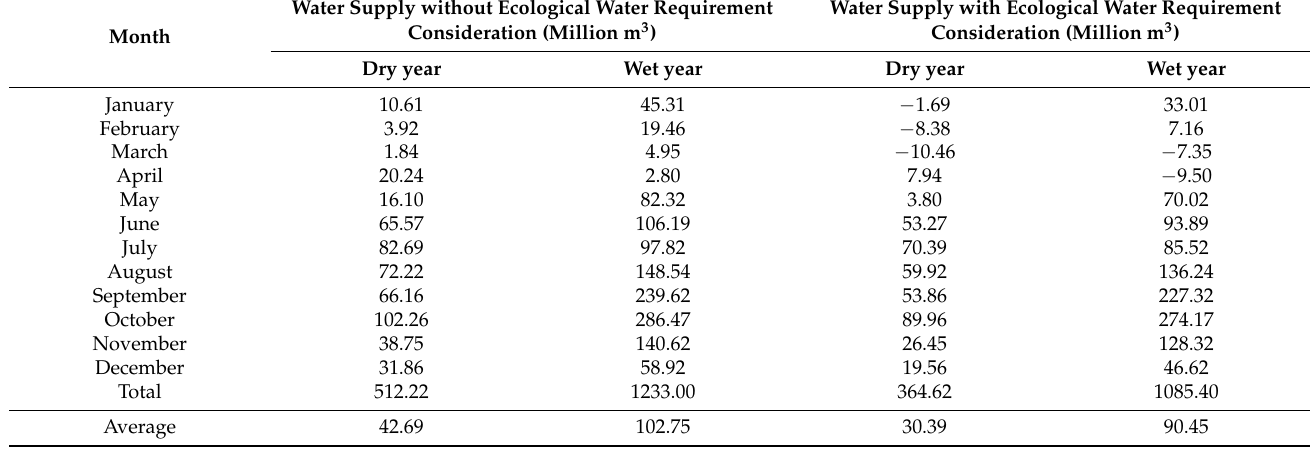
Table A4. Monthly water supply without and with the consideration of ecological water requirements under dry and wet year scenarios between 2020 and 2029.